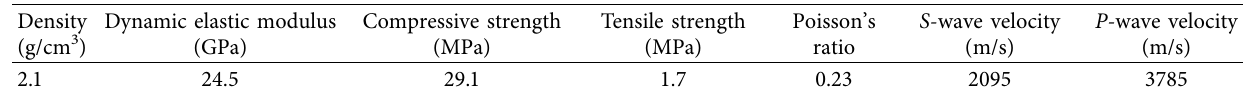
Figure 2: Schematic of the experimental system. Table 1: Relevant material parameters of the concrete model.